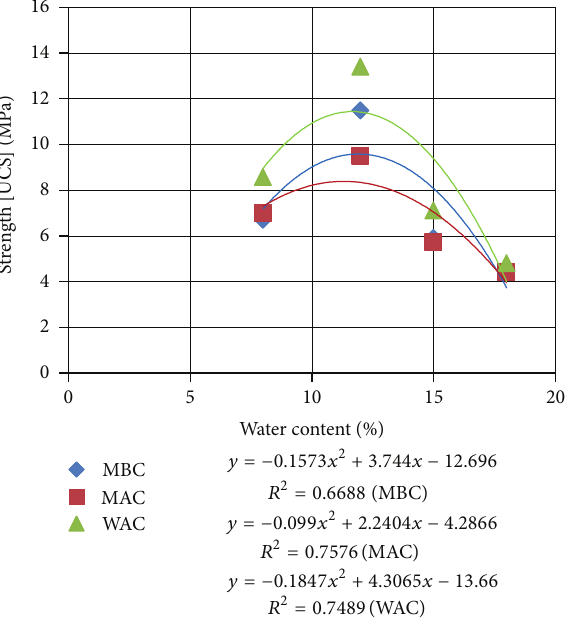
Figure 19: UCS for different water contents (12% cement) (dry durability condition).